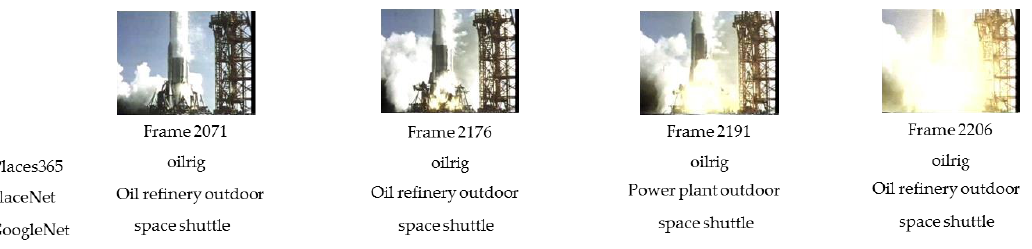
Table 7. The classification accuracy on our validation and test datasets of pre-trained